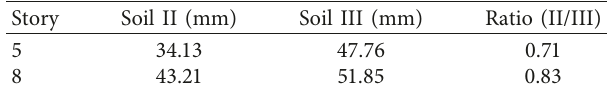
Figure 16: Maximum floor displacement variations of (a) 5-story and (b) 8-story frames under far-field records. Table 13: Average of maximum floor displacement under far-field records.